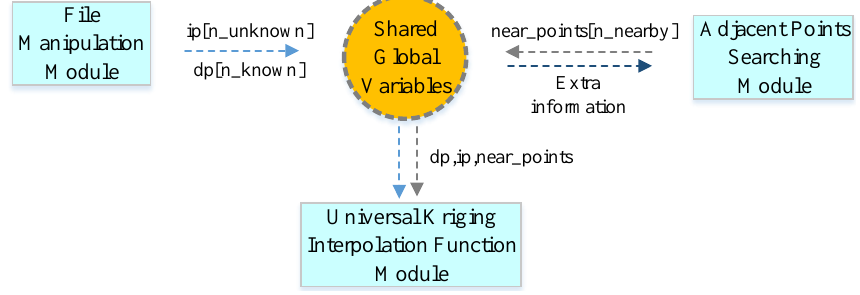
Figure 1. Modules in the serial universal kriging algorithm.